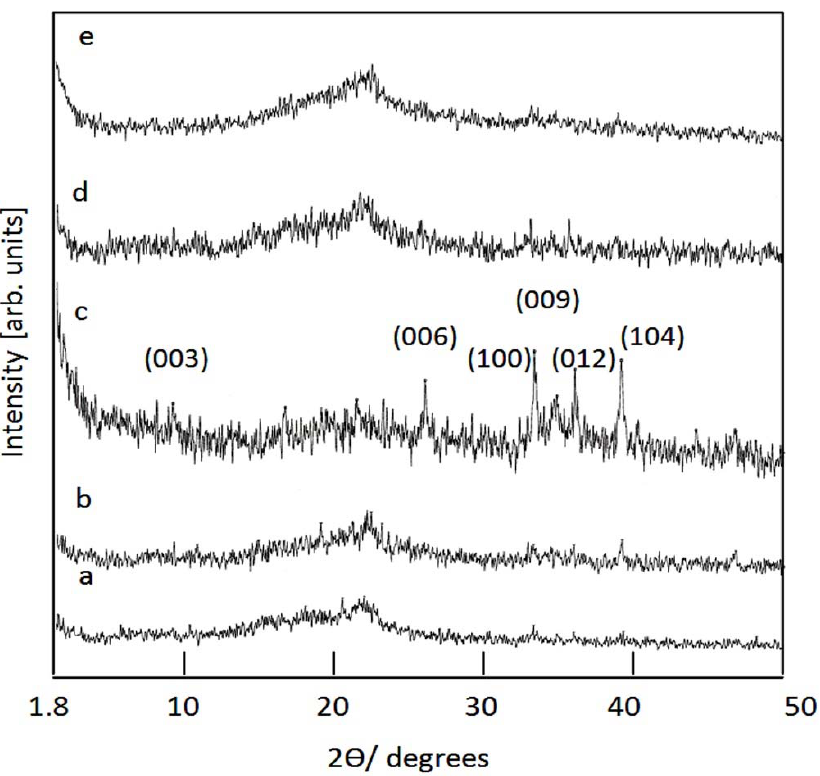
Figure 3. X ‐ ray diffraction of Si/Co LDH: ( a ) SiCo ‐ 1 ‐ 16; ( b ) SiCo ‐ 1 ‐ 20; ( c ) SiCo ‐ 1 ‐ 26; ( d ) SiCo ‐ 1 ‐ 36; and ( e ) SiCo ‐ 2 ‐